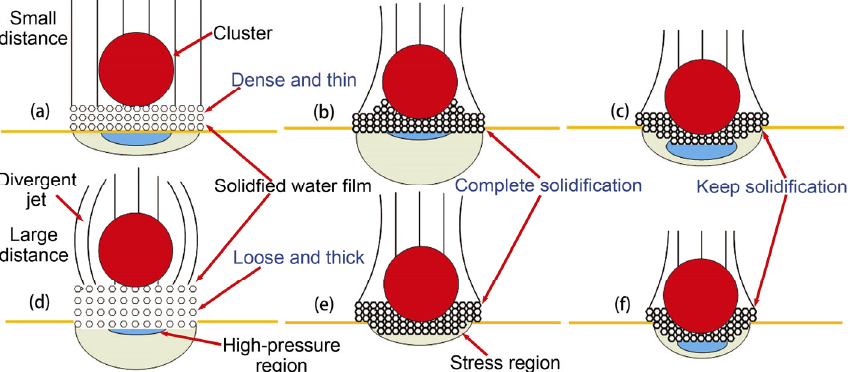
Fig. 14 Sketch of the process of AWJ impingement on substrate. (a), (b), and (c) are at small standoff distance; (d), (e), and (f) are at large standoff distance. (a), (d) represent the moment that the water film starts to solidity; (b), (e) represent the moment of the water film complete solidification; (c), (f) represent the moment that substrate reaches maximum